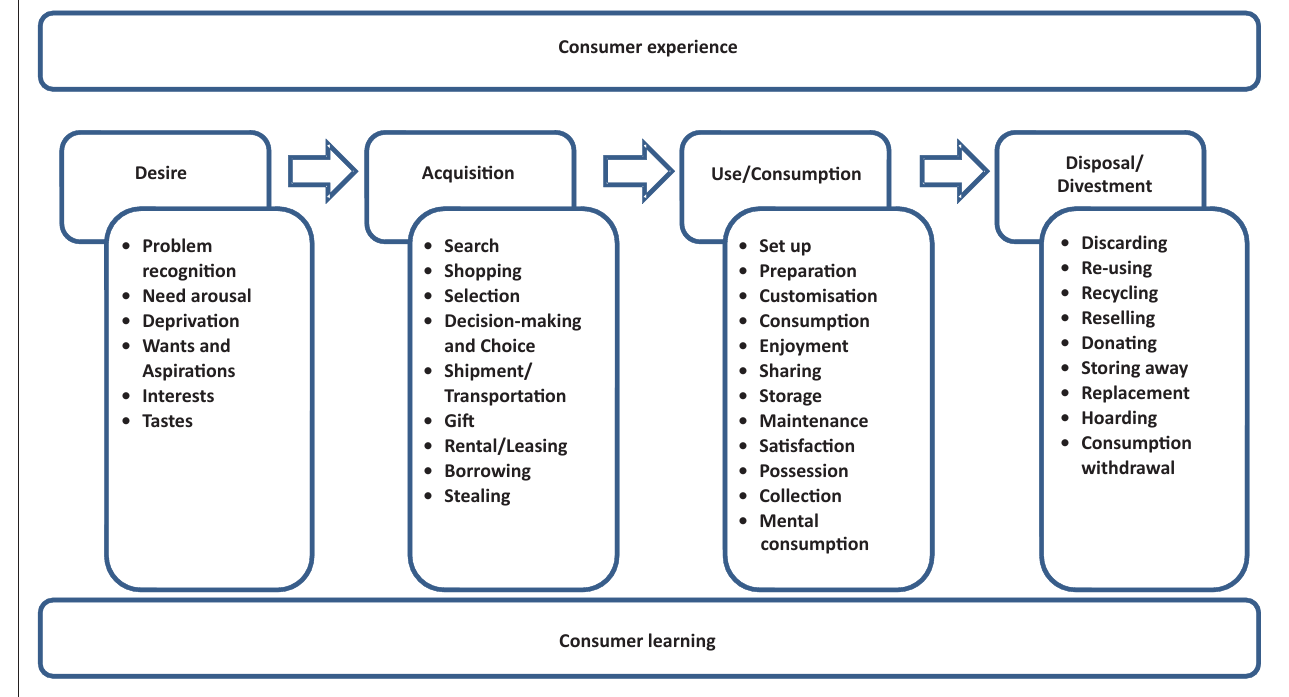
FIGURE 1: The scope of consumer